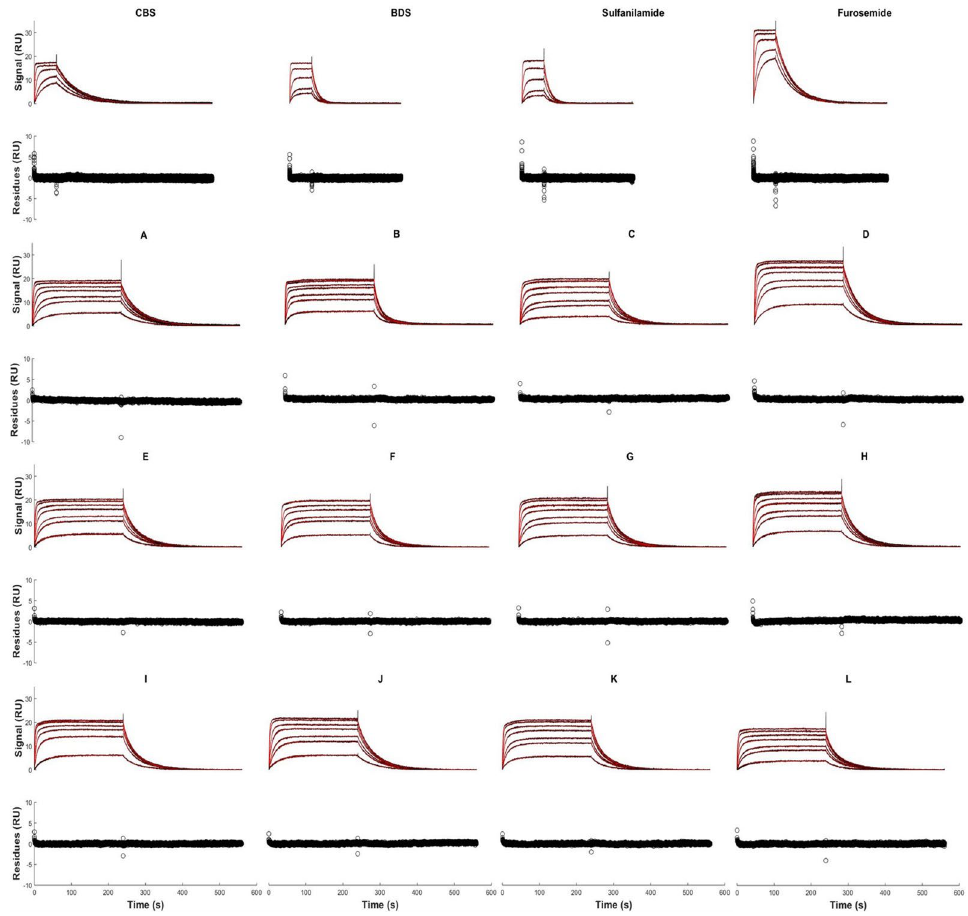
Figure 3. Kinetic analysis of the injection of the 4 compounds and the 12 mixtures of compounds. Black dots correspond to control-corrected and double referenced sensorgrams for all experiments. Red lines correspond to global fits for the single-analyte experiments (CBS, BDS, sulfanilamide and furosemide) and to ‘global–global’ fits for each data set for 70–10–10–10 mixtures (A to D, see Table 1 for exact composition), 40–20–20–20 mixtures (E to H, see Table 1 for exact composition) and random proportion mixtures (I to L, see Table 1 for exact composition). For the single-analyte experiments, the concentrations of CBS, BDS, sulfanilamide and furosemide varied respectively from 1.06 μM to 52.98 μM, 210 nM to 10.49 μM, 1.01 μM to 50.27 μM and 1.01 μM to 50.52 μM. The total concentrations ( C TOT ) of the mixtures varied from 300 nM to 15 μM for